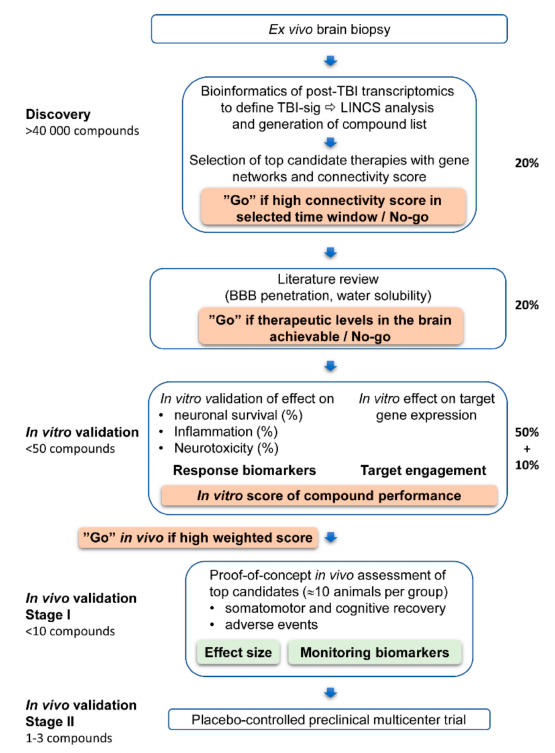
Figure 1. Overview of the pipeline for in vitro and in vivo validation of in silico-derived candidate treatments for traumatic brain injury (TBI). Weighted scoring scheme is presented in Sections 2.4 and 4.2.5. Percentage on the right indicates the weight of each component in the total score. On the left we indicate our rough estimate on filtering-out of the compounds during the procedure within a 3-y time frame based on the data obtained. Discovery phase: Bioinformatics of mRNA-sequencing (seq) data of tissue sampled from the brain region of interest. For example, we sampled the perilesional cortex, which is critical for epileptogenesis after TBI. The data are used to generate a TBI transcriptomics signature (TBI-sig) that is then compared with the compound-induced transcriptomics signature (compound-sig), for example, in the iLINCS database, which includes over 40,000 compound-sig (http: // www.ilincs.org). A list of compounds with concordance scores